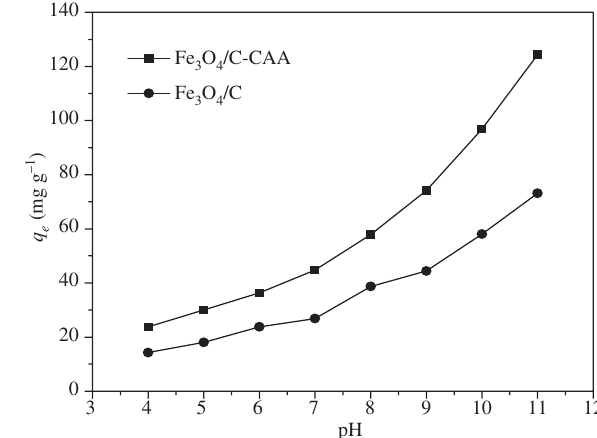
O /C is modified 3 4 O /C-CAA microspheres at 3 4